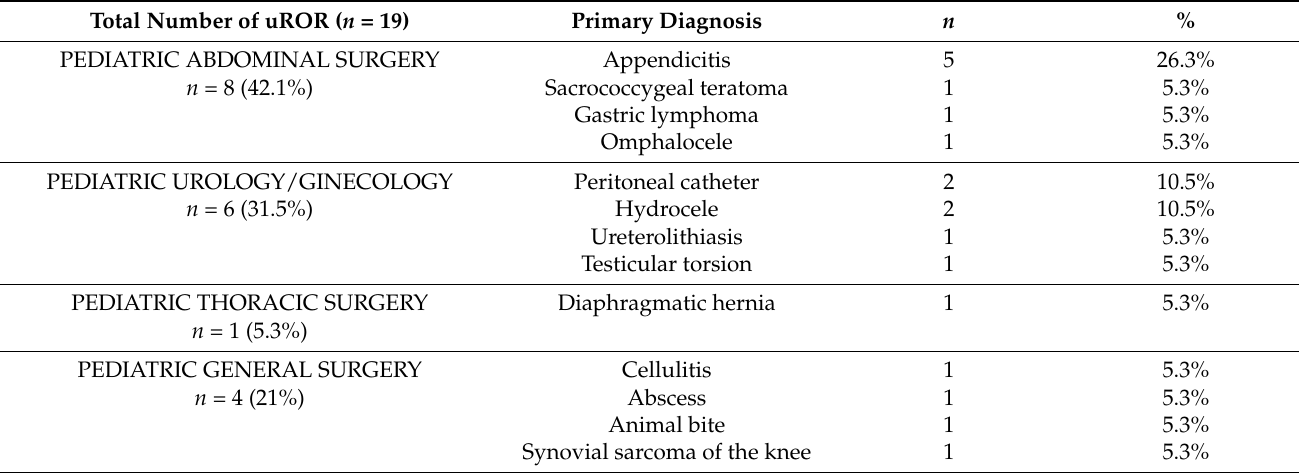
Table 5. Diagnoses that caused uROR in the 30-day postoperative period.